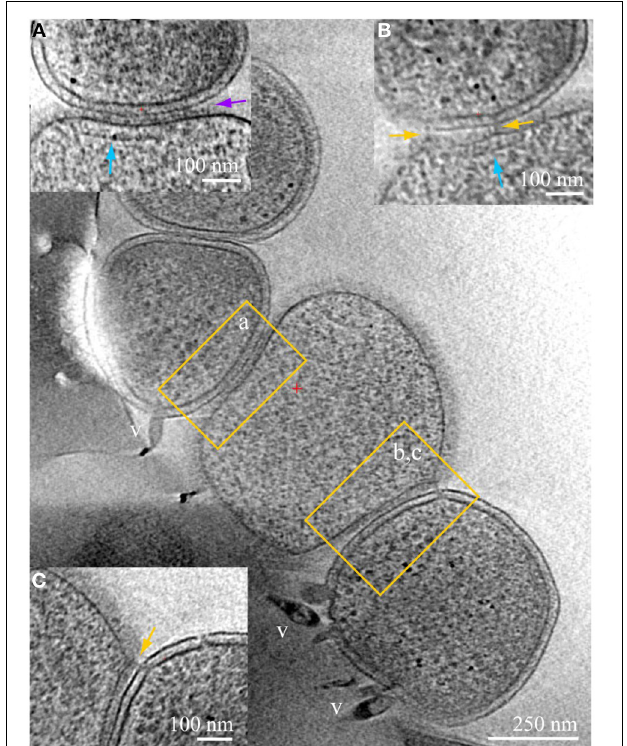
FIGURE 3 | ARMAN— Thermoplasmatales inter-species associations and viral infection processes. Slices from a 3D cryo-ET reconstruction of a colony of cells showing contacts and associations between a Thermoplasmatal lineage cell (center, no cell wall) and two ARMAN cells infected with viruses (gram-negative like cell wall, top left, and bottom right). Insets represent slices at different orientations, of the regions within yellow boxes in the main z-slice. In inset (A) the cell surfaces are in tight contact, with a distinct line of density at the interface pointed by the purple arrow. Thermoplasma lineage archaea cells engaged in this type of association typically have a cytoplasmic band of density parallel to the plasma membrane, indicated here by the vertical blue arrow. These features resemble, to some extent, bacterial chemotaxis apparatus (Milne and Subramaniam, 2009), but AMD Thermoplasmatales lineage archaea have no identified chemotaxis genes. Inset (B) is a slice at an orientation that exactly contains a filamentous connection between the cells that clearly crosses the cell wall; the same band of density as in (B) is indicated by a blue arrow. Inset (C) is another slice of the same region, at different coordinates (z-height and angles), with pili-like connections through the cell wall. The ARMAN cells involved in the interactions shown in insets (A–C) are infected by rod-shape and lemon shaped viruses some of which are clear and labeled “v.” See also Figures S2–S6 and Movie 4